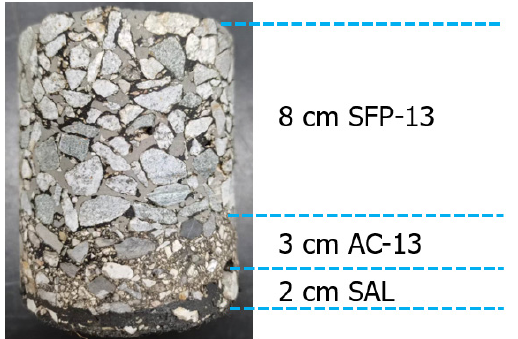
Figure 2. The structural composition of ART pavement incorporating an SFP layer. In order to monitor the stress–strain state of the semi-flexible ART pavement under vehicles of the ART system, sensors were buried in the test section of the pavement to continuously track and observe the mechanical response of the pavement with a sampling frequency of 5 Hz. Figure 3 shows the photos of the buried sensors on the test section site. Using the monitoring system, the stress–strain response of different layers of the ART pavement could be recorded automatically when the ART vehicle